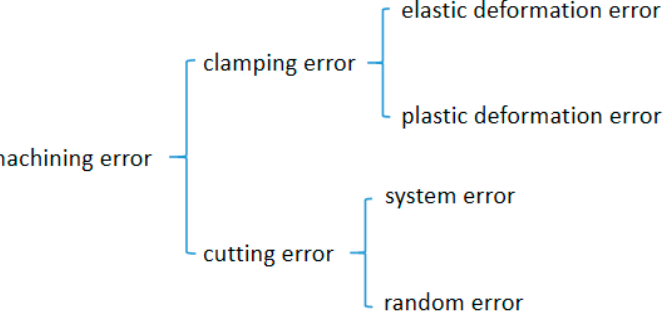
Figure 1. Schematic diagram of machining error distribution.